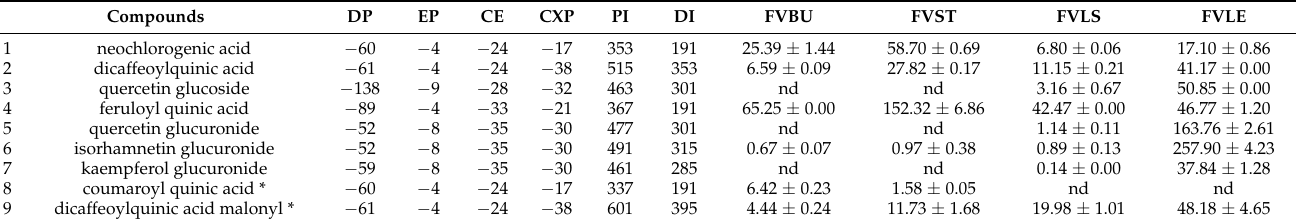
Table 1. Quantitative data obtained from the analysis of selected phenolic compounds in F. vulgare extracts using UHPLC–ESI-QTRAP-MS/MS analyses in MRM